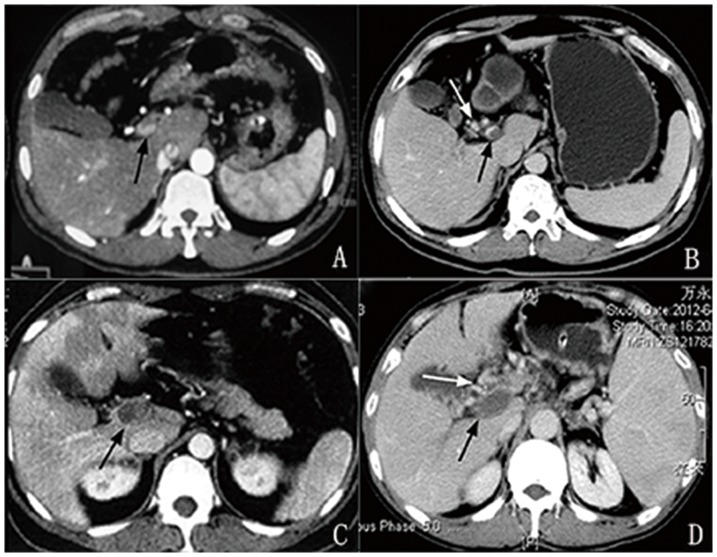
Cross-sectional CT image of portal vein thrombosis and cavernoma: A) partial PVT (black arrow) without cavernoma; B) partial PVT (black arrow) with cavernoma (white arrow); C) complete PVT (black arrow) without carvernoma and D) complete PVT (black arrow) with cavernoma (white arrow).